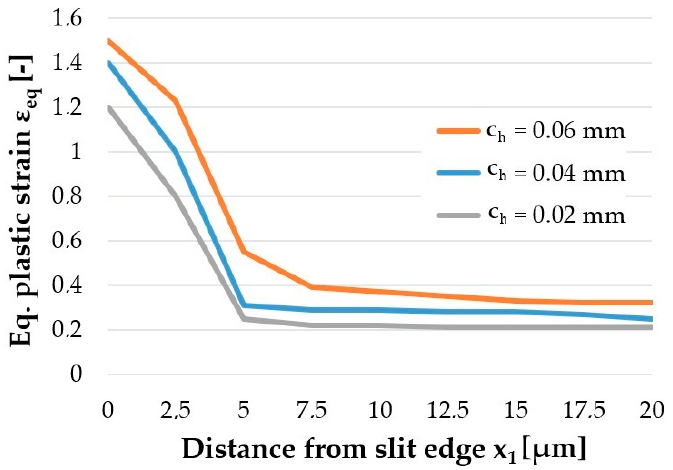
Figure 7. Formation of slit edges along the shearing line: ( a ) 25% of sheet length; ( b ) 100% of sheet length ( c h = 0.04 mm, α = 15°).